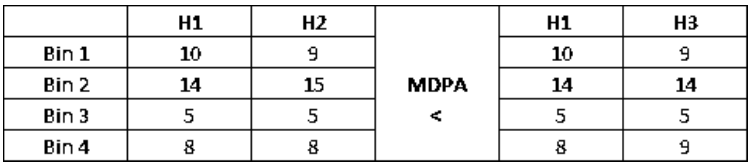
Figure 5. MDPA distance example. This distance is smaller for H1 and H2 than for H1 and H3. The Euclidean distances are